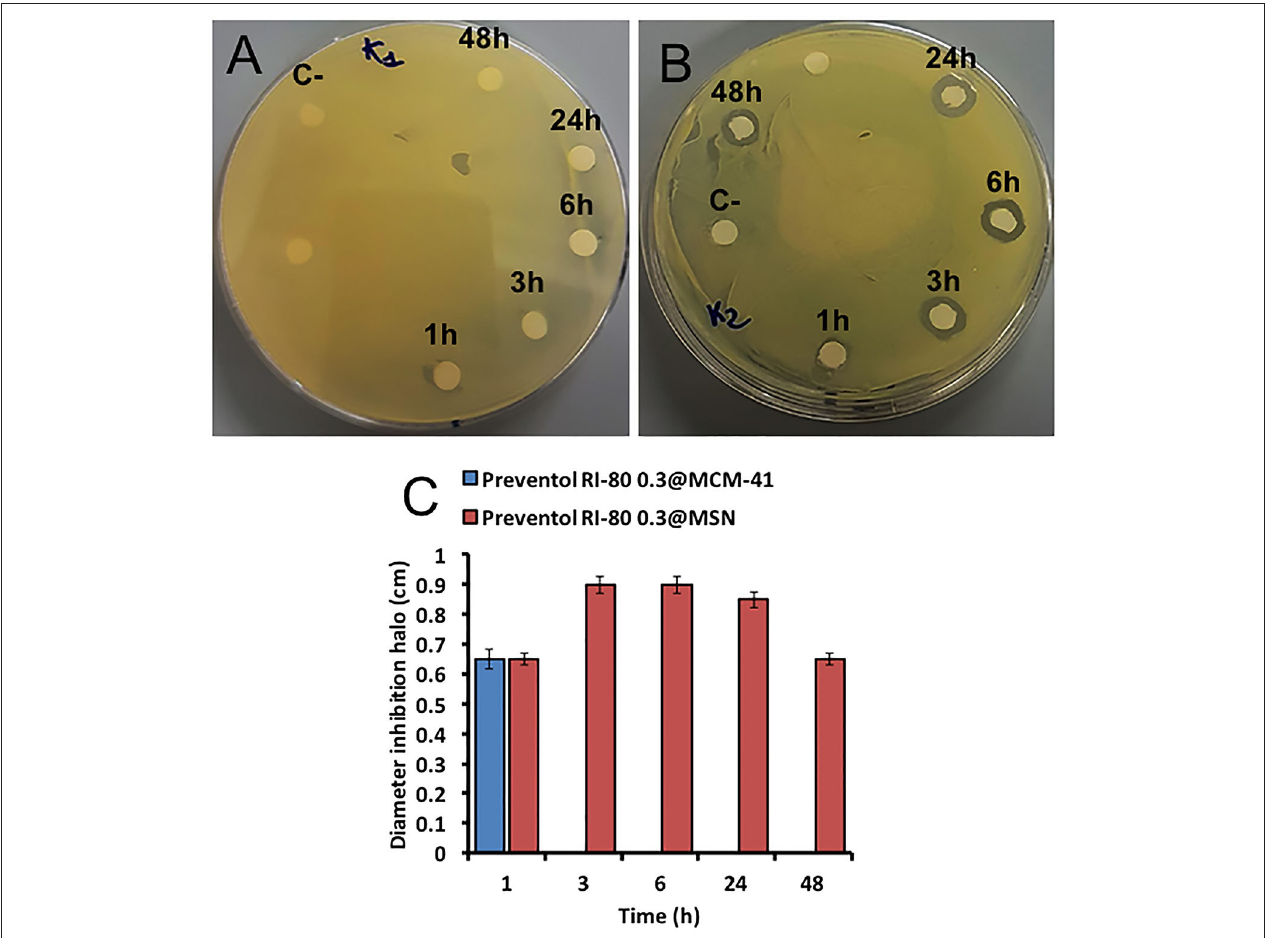
FIGURE 6 | Microbiological assays using K. rhizophila as tester strain. Antimicrobial activity of both Preventol RI-80 0.3@MCM-41 (A) and Preventol RI-80 0.3@MSN (B) CRSs, while the bar graph in (C) shows the actual diameter size of the inhibition halos, over time, ascribed to Preventol RI-80 0.3@MCM-41 (blue) and Preventol RI-80 0.3@MSN (red) systems